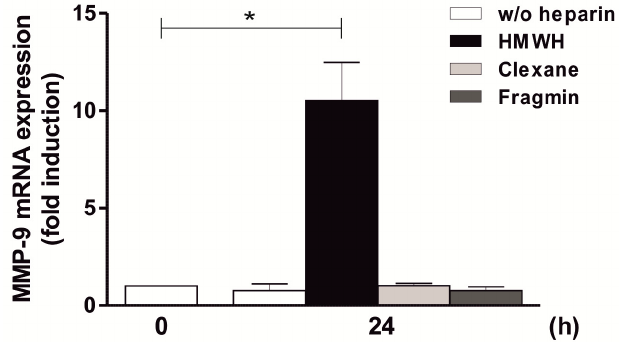
Figure 5. No Induction of MMP-9 expression by LMWH in a THP-1 and Jurkat cells containing co-culture. 1 × 10 6 THP-1 and Jurkat cells (i.e., a total of 2 × 10 6 cells/well) were starved overnight. Afterwards, the co-culture was stimulated with HMWH (as a positive control), Clexane, or Fragmin (50 IU/well each) for 24 h. Then, MMP-9 mRNA expression was determined using qPCR (QuantiTect Custom Assay; housekeeping gene: GAPDH); mean ± SD, n = 3 (measured in duplicates). T test, * p ≤ 0.05. Table 1. Cytokines/chemokines expressed by HMWH-treated THP-1, Jurkat, and HT cells as determined by Proteome Profiler Human XL Cytokine Array. T cell-specific IL-16 and co-culture-specific IL-8 are highlighted in